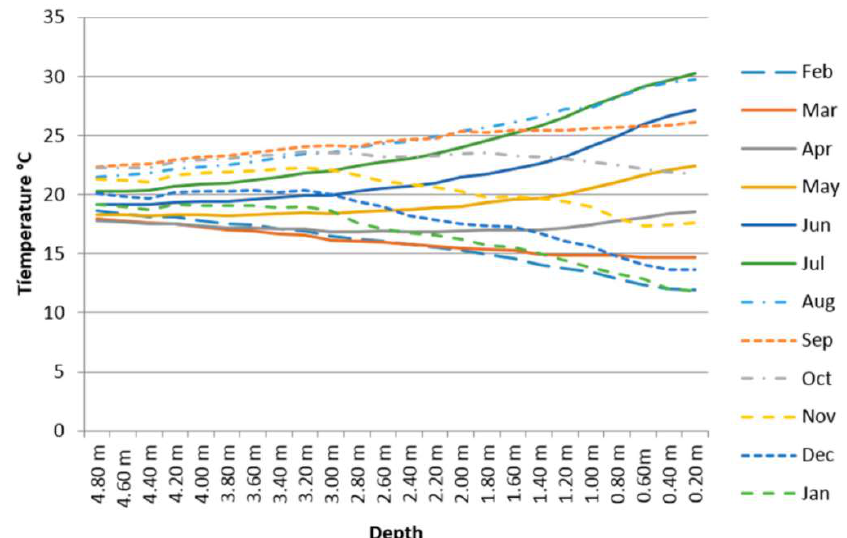
Figure 16. Variation of the monthly average temperature of the ground with the depth of the Casa Zaranda site.